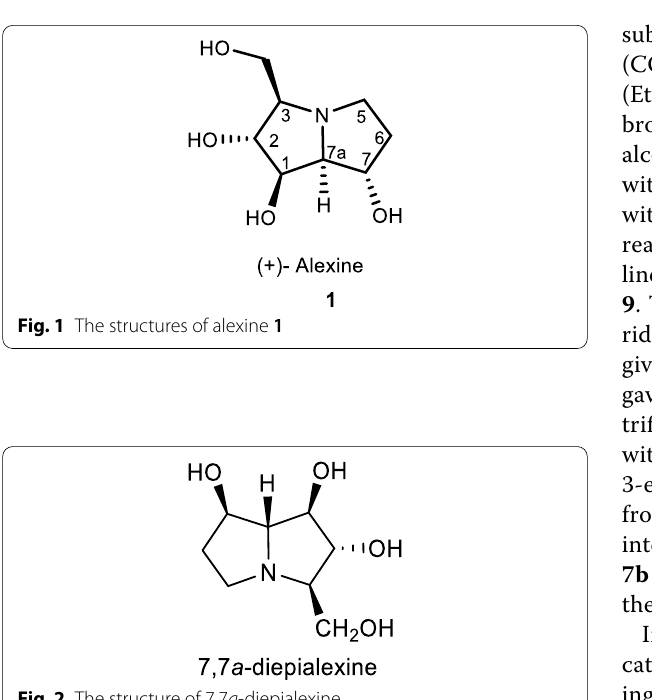
Fig. 2 The structure of 7,7 a -diepialexine